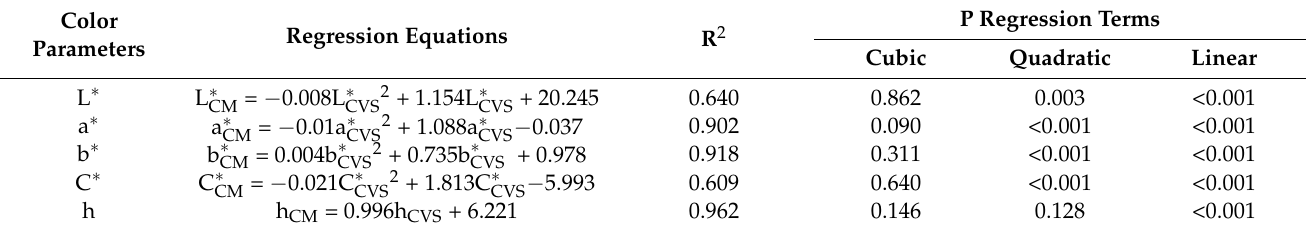
Figure 4. Regression curve for L*, a*, b*, C*, and h: ( a ) L (cid:2887)(cid:2897)∗ − L (cid:2887)(cid:2906)(cid:2903)∗ ; ( b ) a (cid:2887)(cid:2897)∗ − a (cid:2887)(cid:2906)(cid:2903)∗ and b (cid:2887)(cid:2897)∗ − b (cid:2887)(cid:2906)(cid:2903)∗ ; ( c ) C (cid:2887)(cid:2897) ∗ − C (cid:2887)(cid:2906)(cid:2903) ∗ ; ( d ) h (cid:2887)(cid:2897) ∗ − h (cid:2887)(cid:2906)(cid:2903) ∗ . Table 3. Best regressions of L*, a*, b*, C*, and h of jadeite-jade evaluated by using a colourimeter over values from the computer vision system.